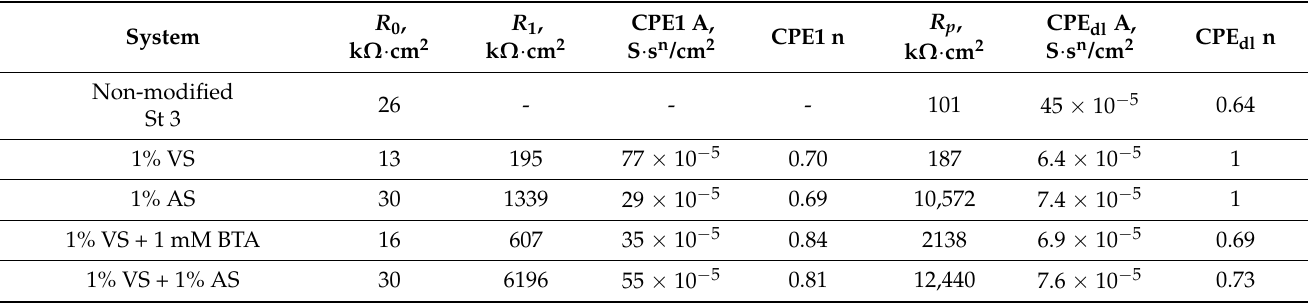
Table 5. Parameters of equivalent circuits used for simulation of EIS results on steel in solution